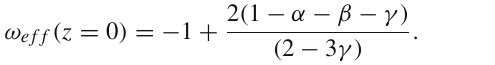
The present value ( h = 1) of ω ef f is found to